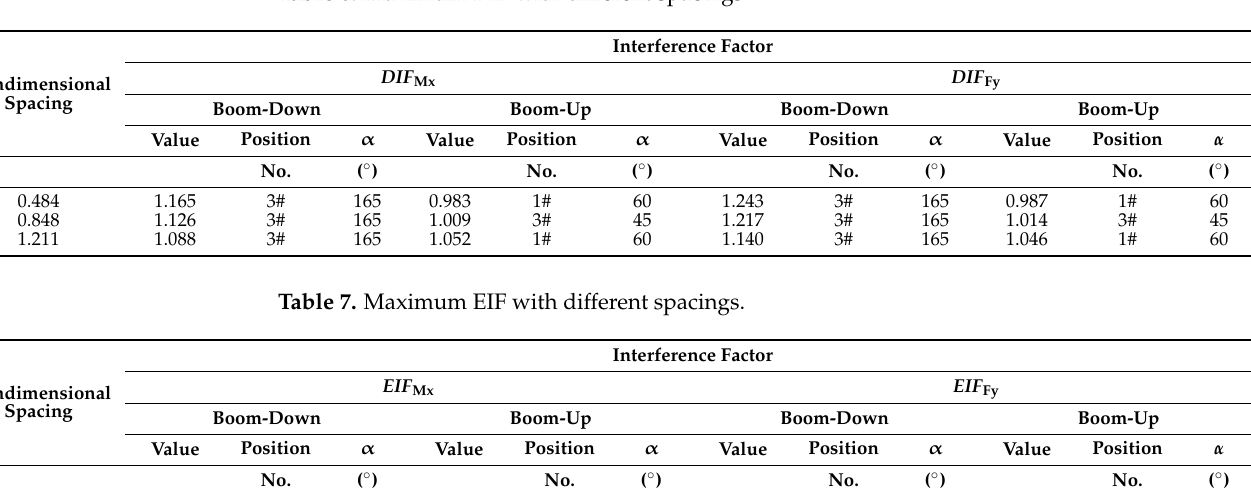
Table 6. Maximum DIF with different spacings.